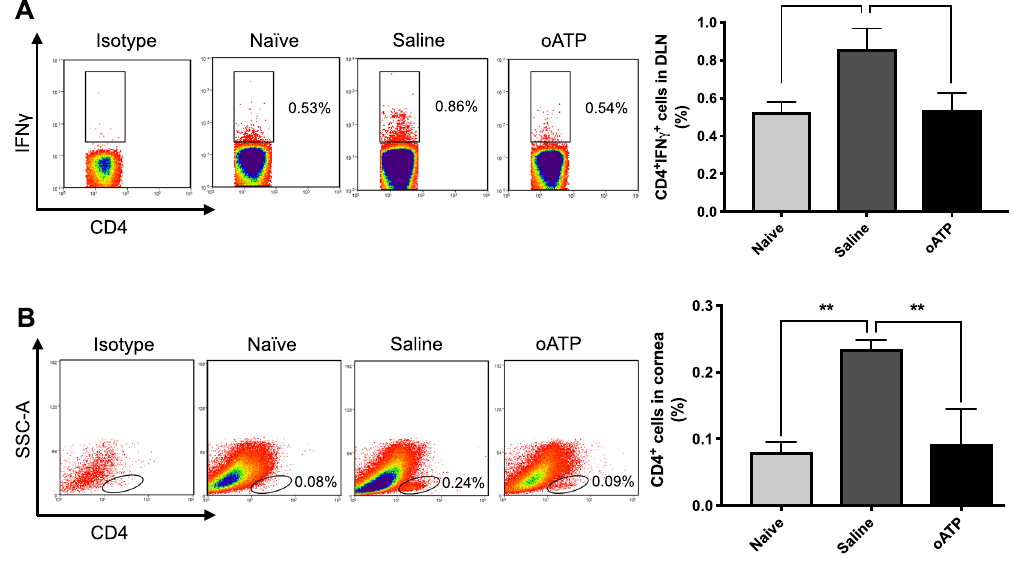
Figure 2. Treatment with oATP suppresses CD4 + effector T cell generation and graft infiltration. ( A ) Representative flow cytometric dot plots (left) and cumulative bar chart (right) showing the frequencies of CD4 + IFN γ + cells (gated on CD4 + cells) in the draining lymph nodes of oATP-treated mice, compared to saline-treated and naïve mice. (B ) Representative flow cytometric dot plots (left) showing the gating strategy for selecting CD4 + cells in the cornea. Bar chart (right) summarizes the frequencies of CD4 + cells in the cornea at 2 weeks post-transplantation, relative to saline-treated and naïve mice. n = 5–7/group. Representative data from three independent experiments are shown, and data are depicted as mean ± SEM. * p < 0.05; ** p < 0.01.